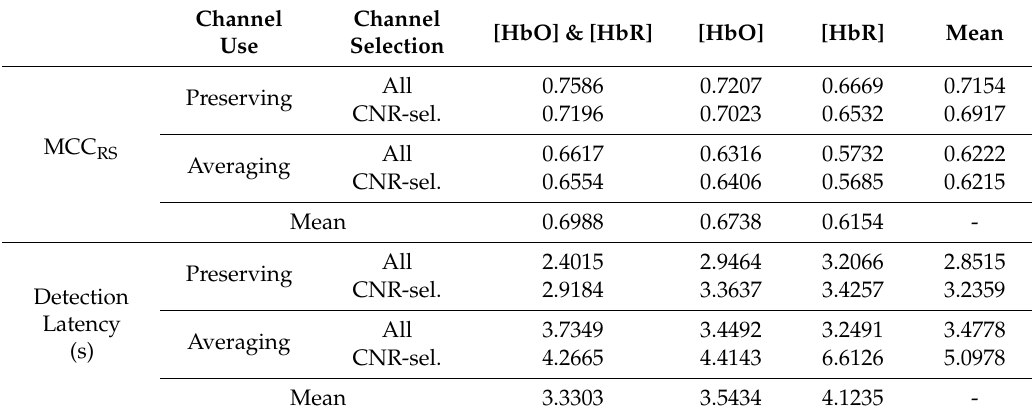
Table 2. Evaluation